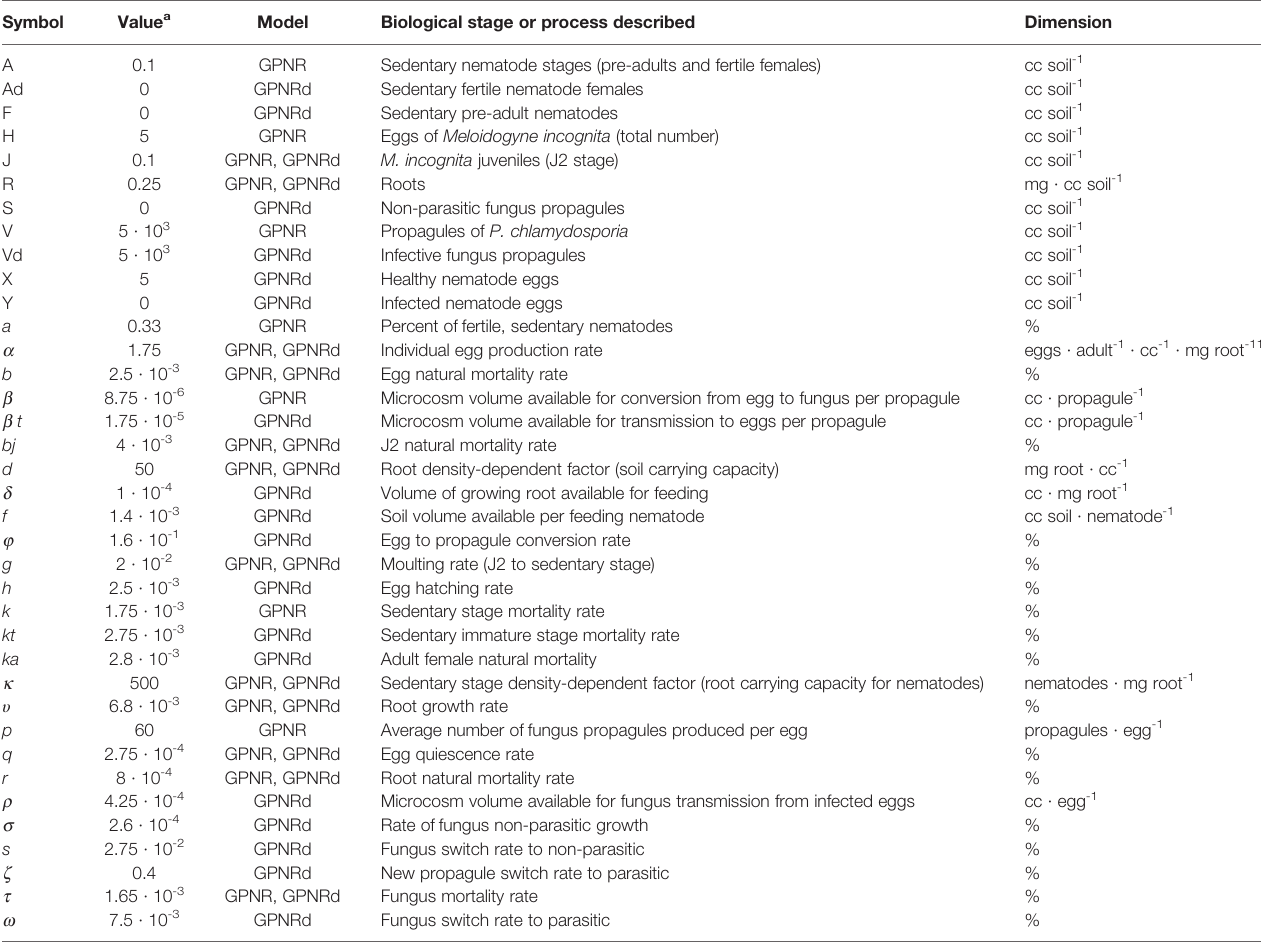
TABLE 1 | Variables (capital letter), constants, and models used for modeling the interactions between the biocontrol fungus Pochonia chlamydosporia and the root- knot nematode Meloidogyne incognita in a rhizosphere microcosm.